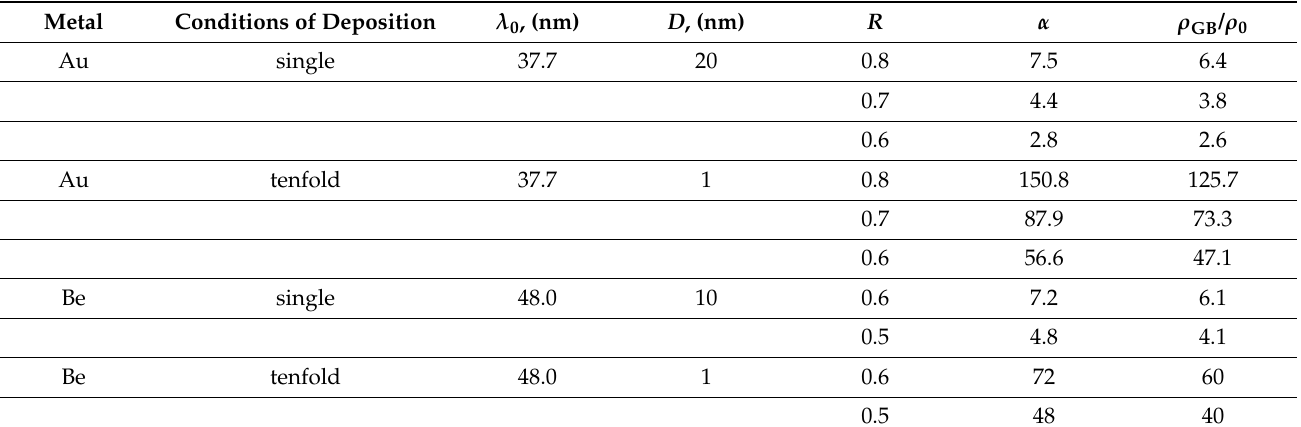
Table 1. The results of calculating the α and ρ GB/ ρ 0 coefficients using Formulas (2) and